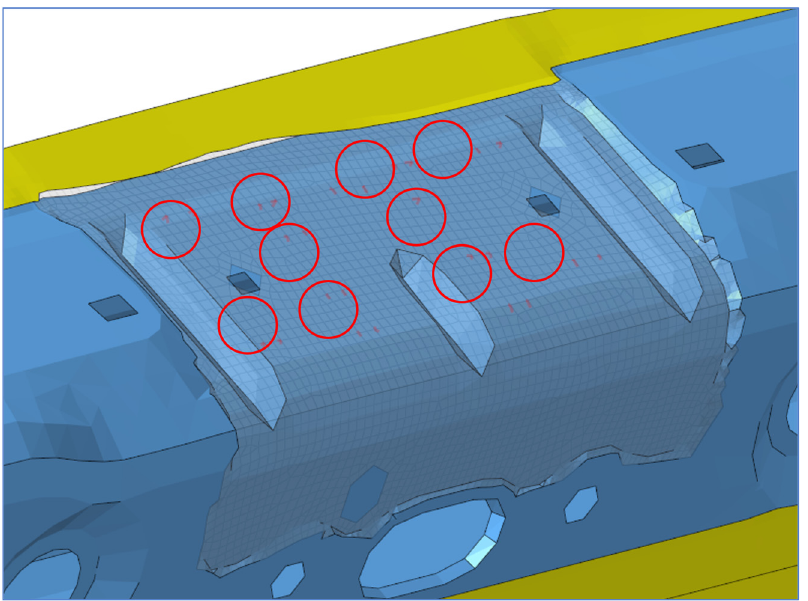
Figure 26. Lock attachment, with highlight of added connections between inner and outer parts (red circles).